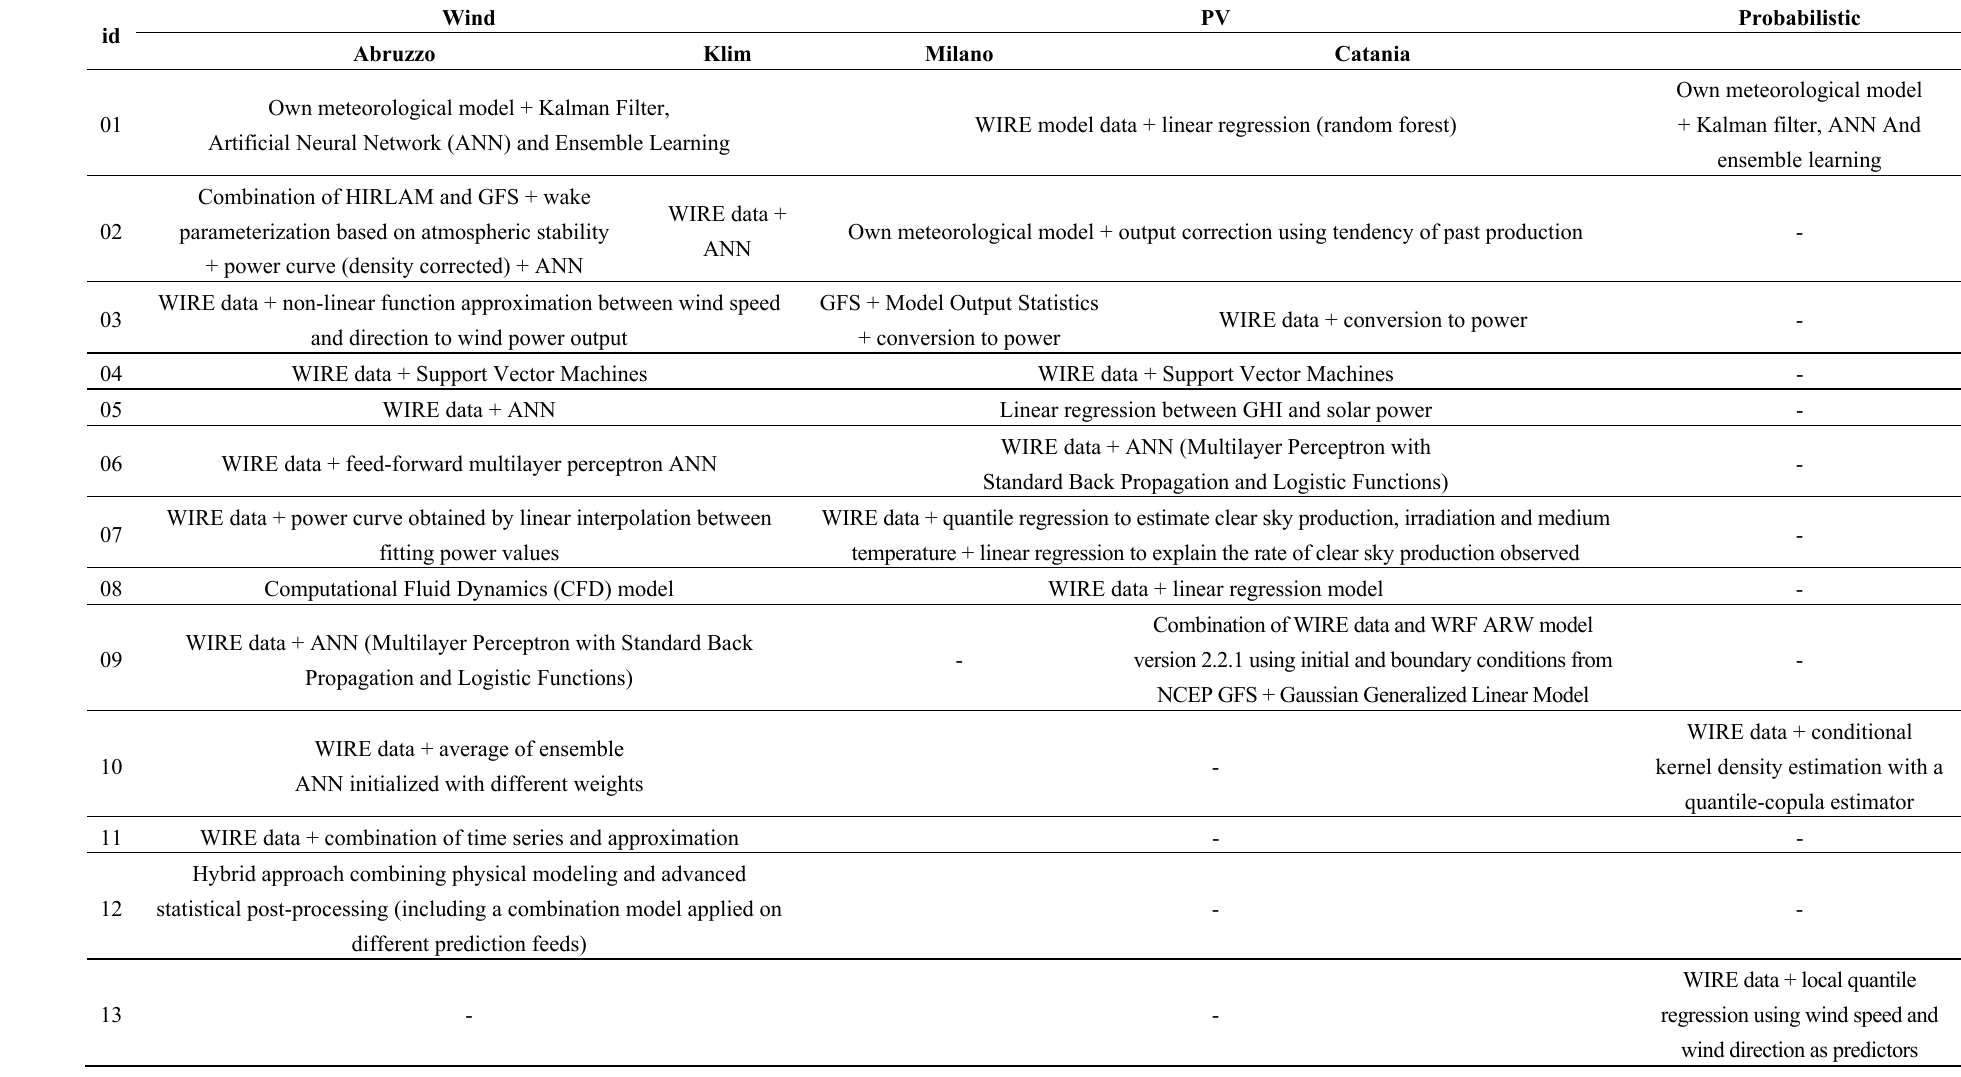
Table 3. List of the forecasting methods used by the participants for each test